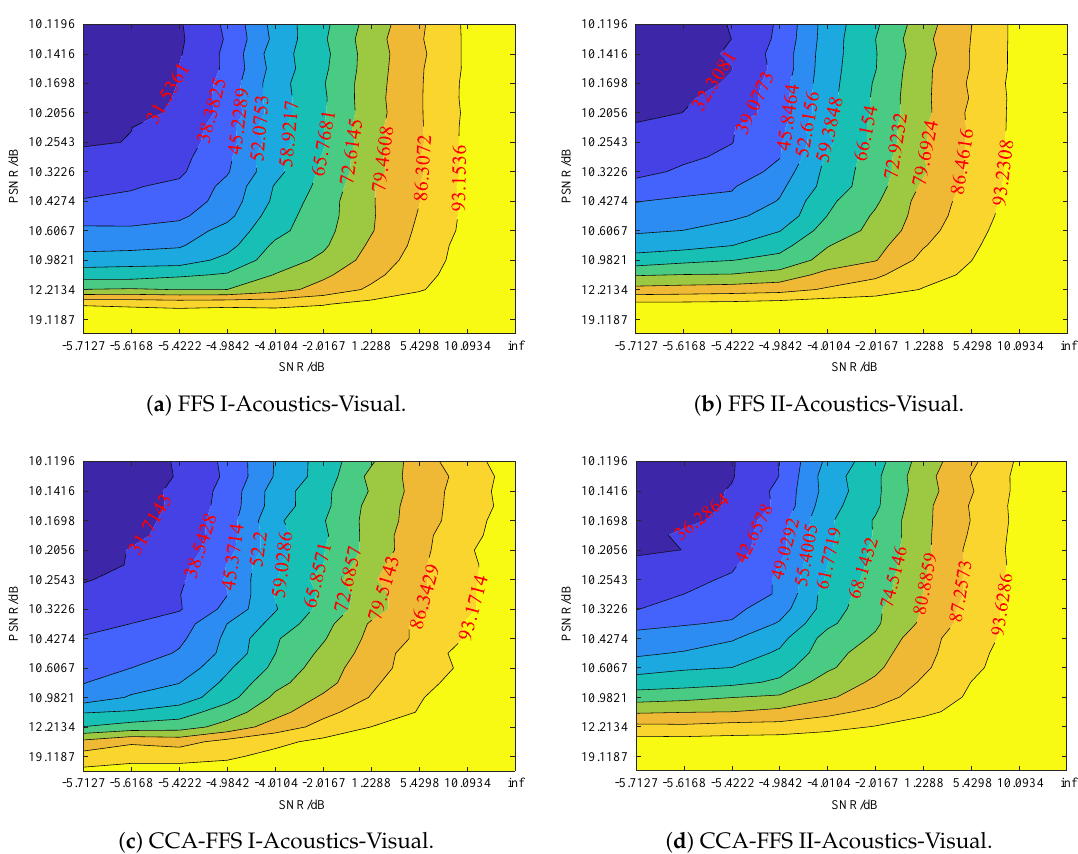
Figure 6. Two-dimensional recognition accuracies (%) of